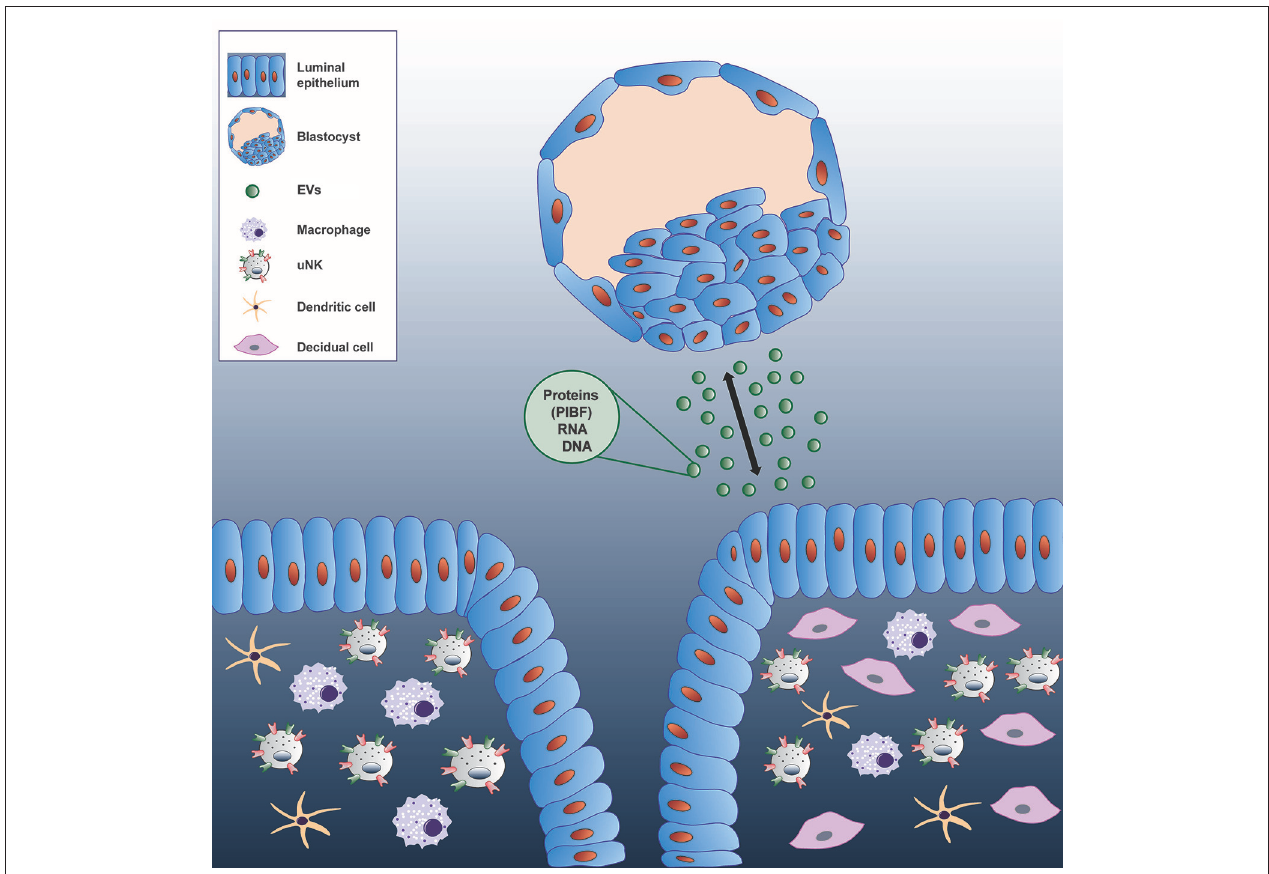
FIGURE 4 | Communication between the embryo and the maternal immune system via extracellular vesicles.